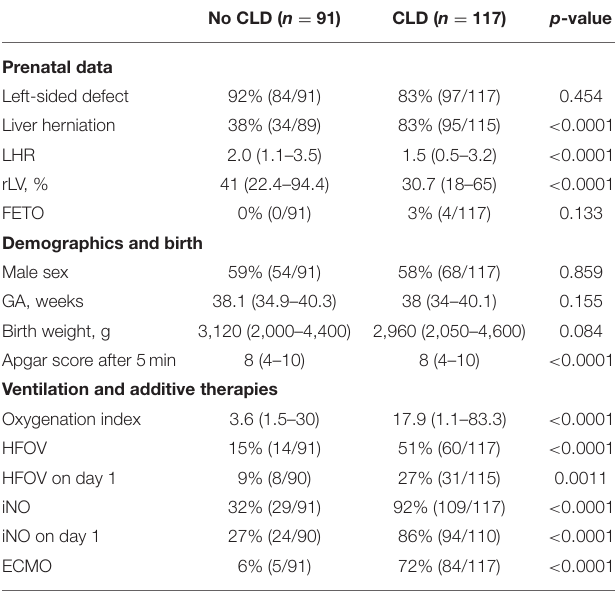
TABLE 4 | Comparison of patient characteristics in relation to